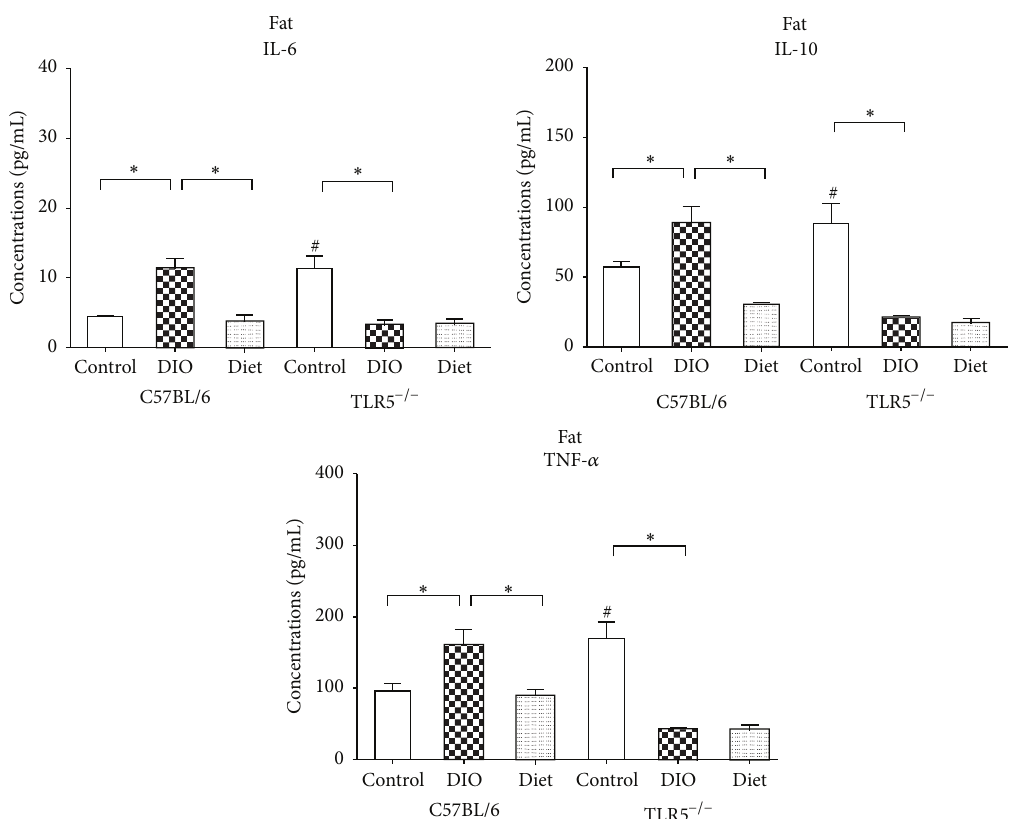
Figure 7: Concentrations of adipose tissue cytokines including IL-6, IL-10, and TNF- 𝛼 at week 12 in C57BL/6 and TLR5 −/− mice in groups of control, DIO, and diet. ∗ 𝑝 < 0.05 versus indicated group. # 𝑝 < 0.05 versus control C57BL/6 mice.